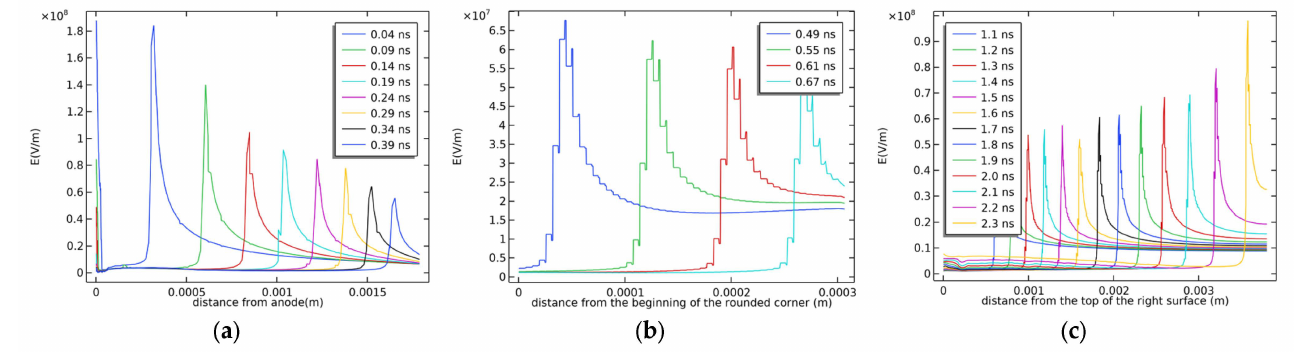
Figure 5. Variation in the electric field intensity of the streamer head. ( a ) Stage 1; ( b ) Stage 2; ( c ) Stage 3.